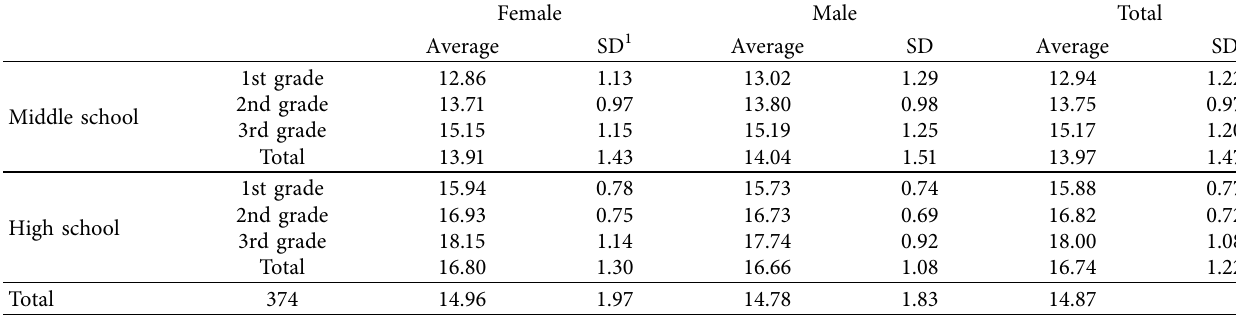
Table 2: Average Age by gender and school cycle.